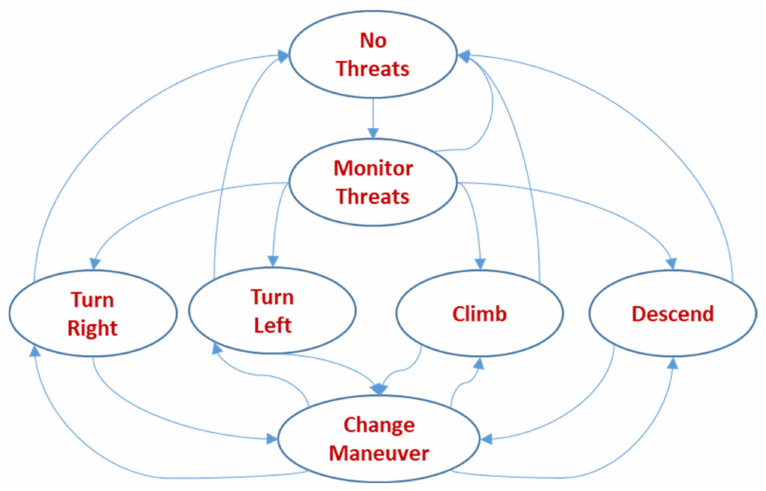
Figure 11. Decision making